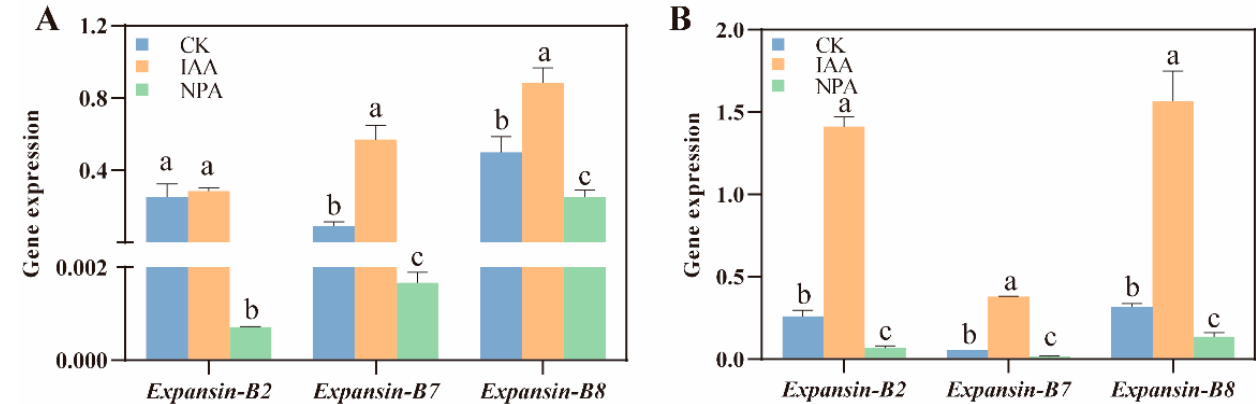
Figure 8. The effect of IAA and NPA treatment to the gene expression of Expansin-B2 , Expansin-B7, and Expansin-B8. ( A ) Relative expression of these three genes in line MS24B; ( B ) Relative expression of these three genes in line Z210. Lowercase letters indicate statistical differences ( p ≤ 0.05) among treatments.